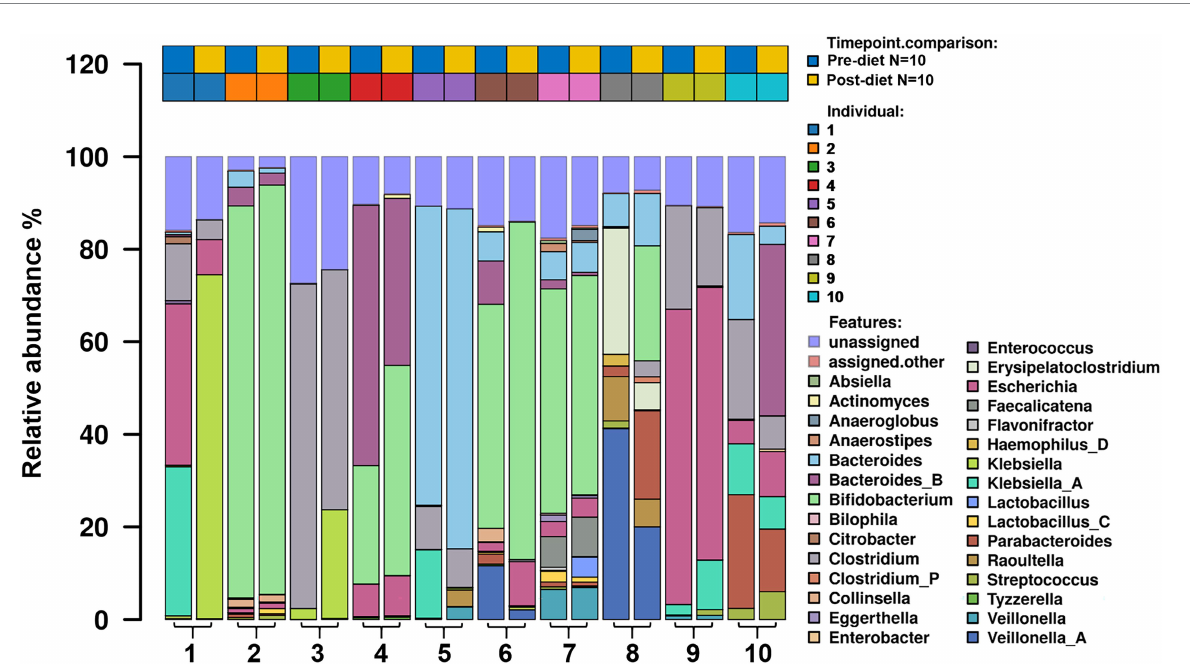
FIGURE 3 The relative abundance of bacterial genera in the infant gut microbiome pre- and post-dietary intervention. Only the top 30 most abundant genera are shown.